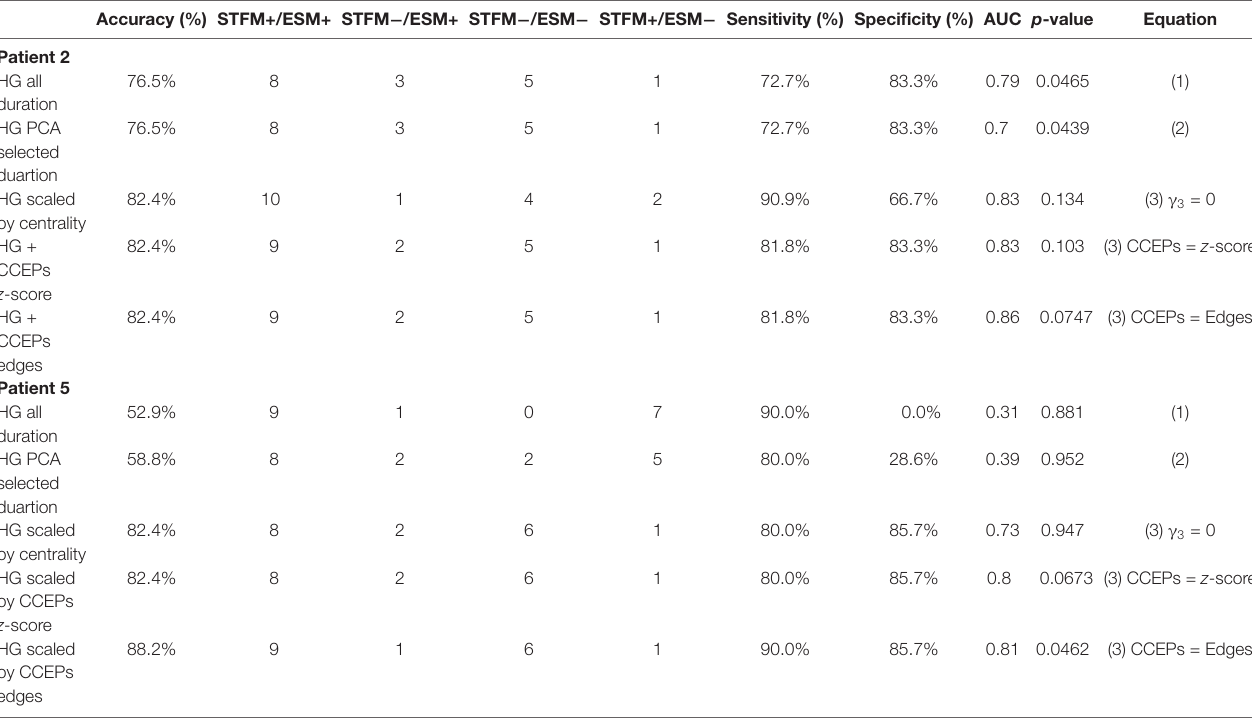
TABLE 2 | Model accuracy for Patients 2 (word reading) and 5 (picture naming).